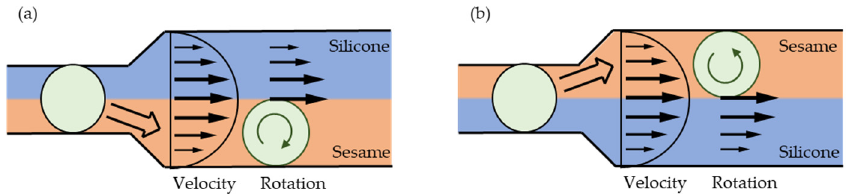
Figure 1. Schematic view of microdroplet rotation inside oil flow in a straight channel. ( a ) Clockwise rotation; ( b ) anti-clockwise rotation.